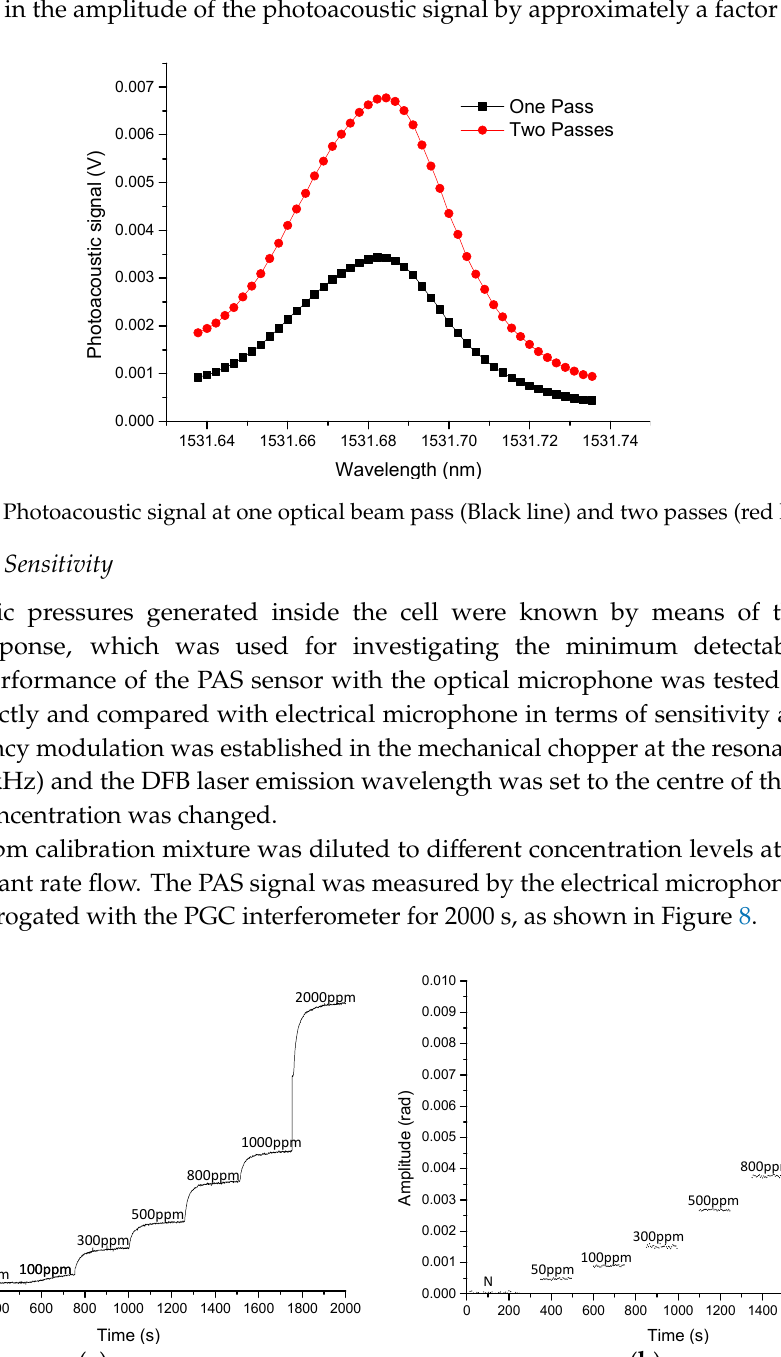
Figure 8. Calibration curve of 0–2000 ppm NH 3 for electrical microphone ( a ) and optical microphone ( b ). Note that while the concentration is stabilized, the data in (b) are not represented. The signal amplitude as a function of NH 3 concentration is plotted in Figure 9. The calculated R 2 value, which represents how well the regression line approximates real data points, is approximately